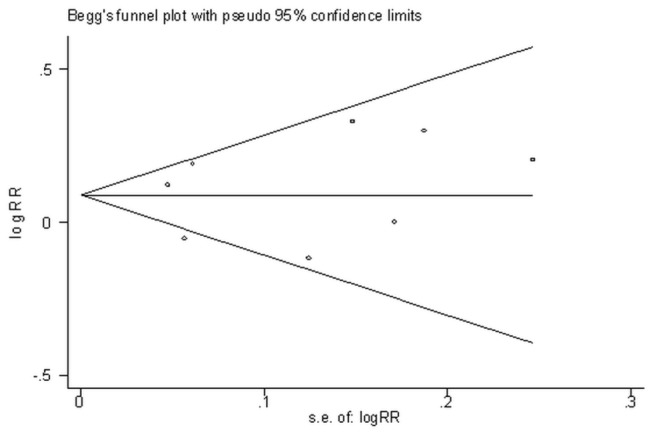
Publication bias.